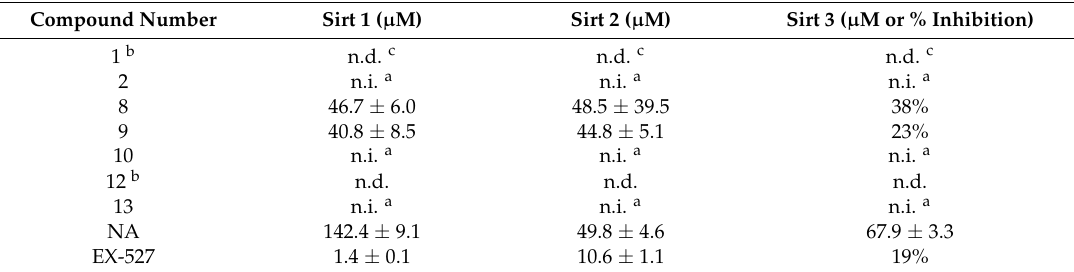
Table 1. IC 50 or percentage inhibitions at 50% of tested pan-African Natural Products Library (p-ANAPL) compounds against sirt1, 2 and 3.